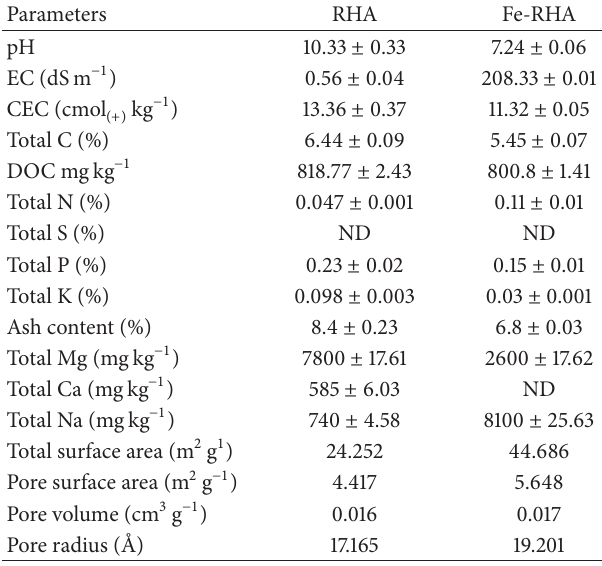
Table 3: The selected physicochemical properties of the RHA and